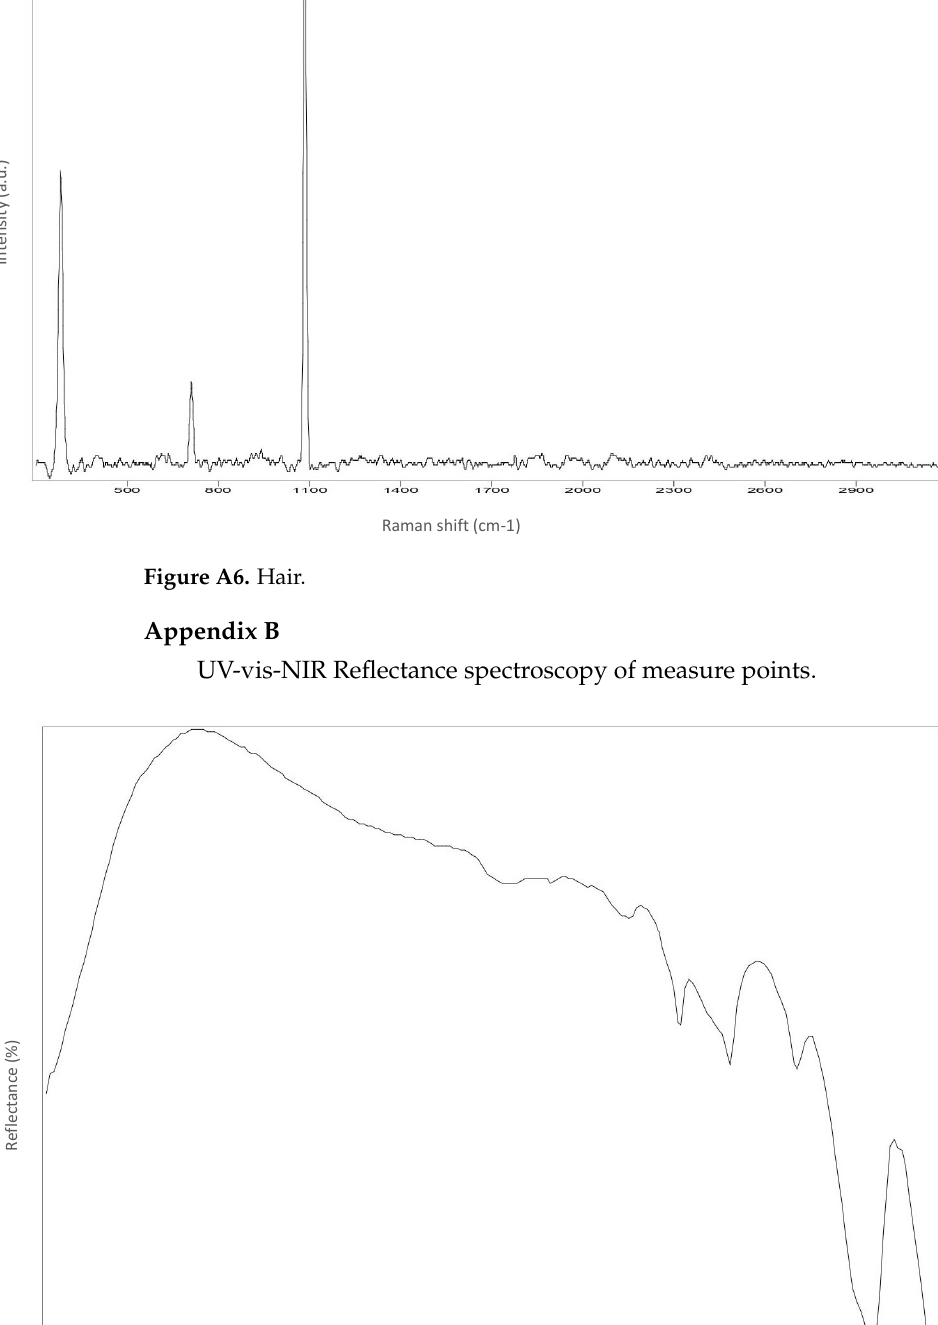
Figure A7. Back-left.